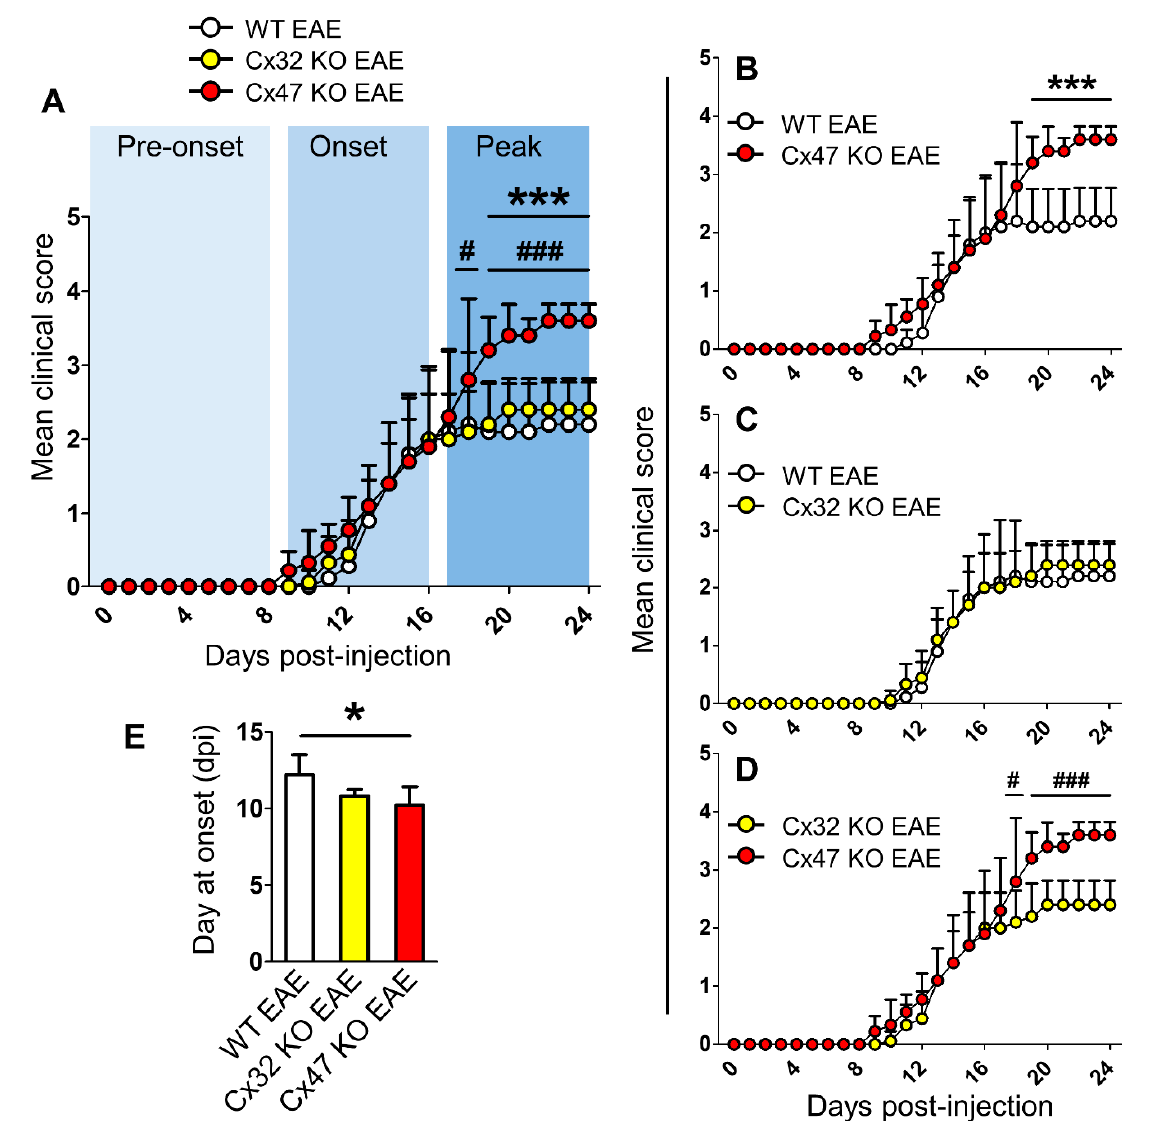
Figure 1: Timeline of clinical course in WT, Cx32 KO, and Cx47 KO EAE mice up to 24 dpi. ( A – D ) Comparison of mean clinical scores (MCS) of WT, Cx32 KO, and Cx47 KO EAE mice ( A ), of WT vs. Cx47 KO EAE mice ( B ), of WT vs. Cx32 KO EAE mice ( C ), and of Cx32 KO vs. Cx47 KO EAE mice ( D ). As mice were sacrificed at 7 days, 12 days, and 24 days post-injection (dpi) for subsequent analyses, the sample size used from each group was as follows: 0–7 dpi ( n = 13 per genotype), 8–12 dpi ( n = 9 per genotype), and 13–24 dpi ( n = 5 per genotype). Data are presented as MCS ± SD.